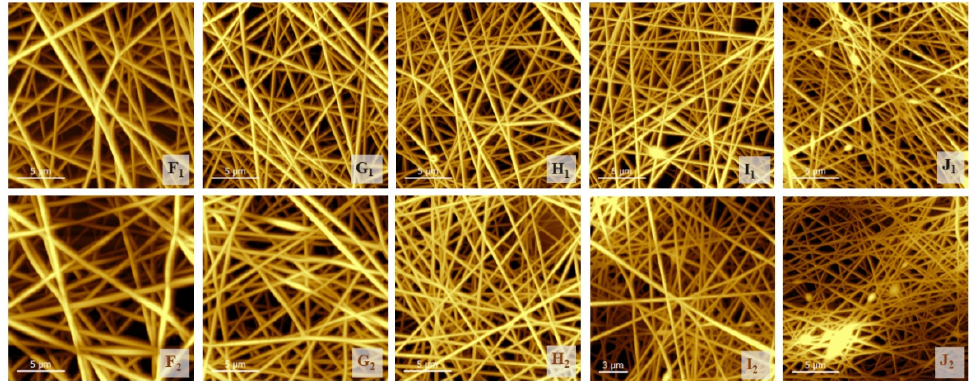
Figure 4. The atomic force images of native (F 1 , G 1 , H 1 , I 1 , J 1 ) and heat-treated (F 2 , G 2 , H 2 , I 2 , J 2 ) sam-